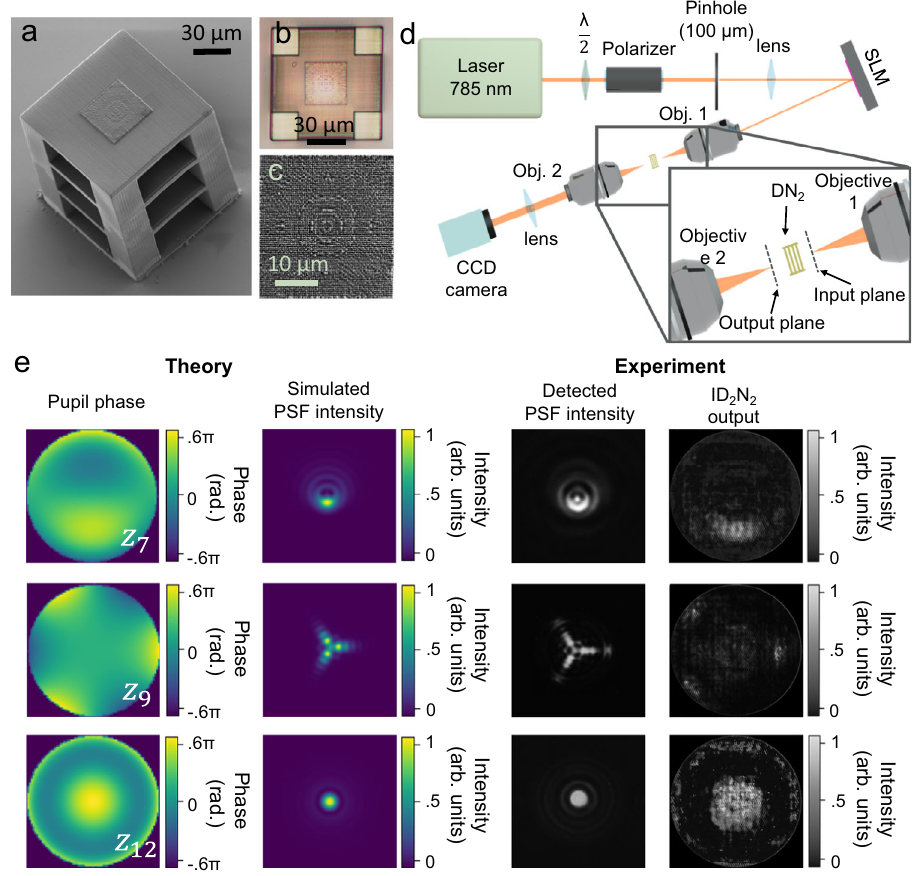
Fig. 4 | Experimental fabrication and characterization. Scanning electron microscope(SEM)image( a )andopticalmicroscopeimage( b )(topview)ofthe laser printed DN 2 . c SEM image of a laser printed diffractive element (layer 4). The radius of each pixels is 400nm, the pixel heights span between 0 and 1.57 µ m for a phase modulation 0 – 2 π and the axial nano-stepping is approxi- mately 10 nm 34 . d Diagram of the laboratory setup used for testing the D 2 N. e Original pupil phases (with RMS absolute magnitude of 0.6 π radians)